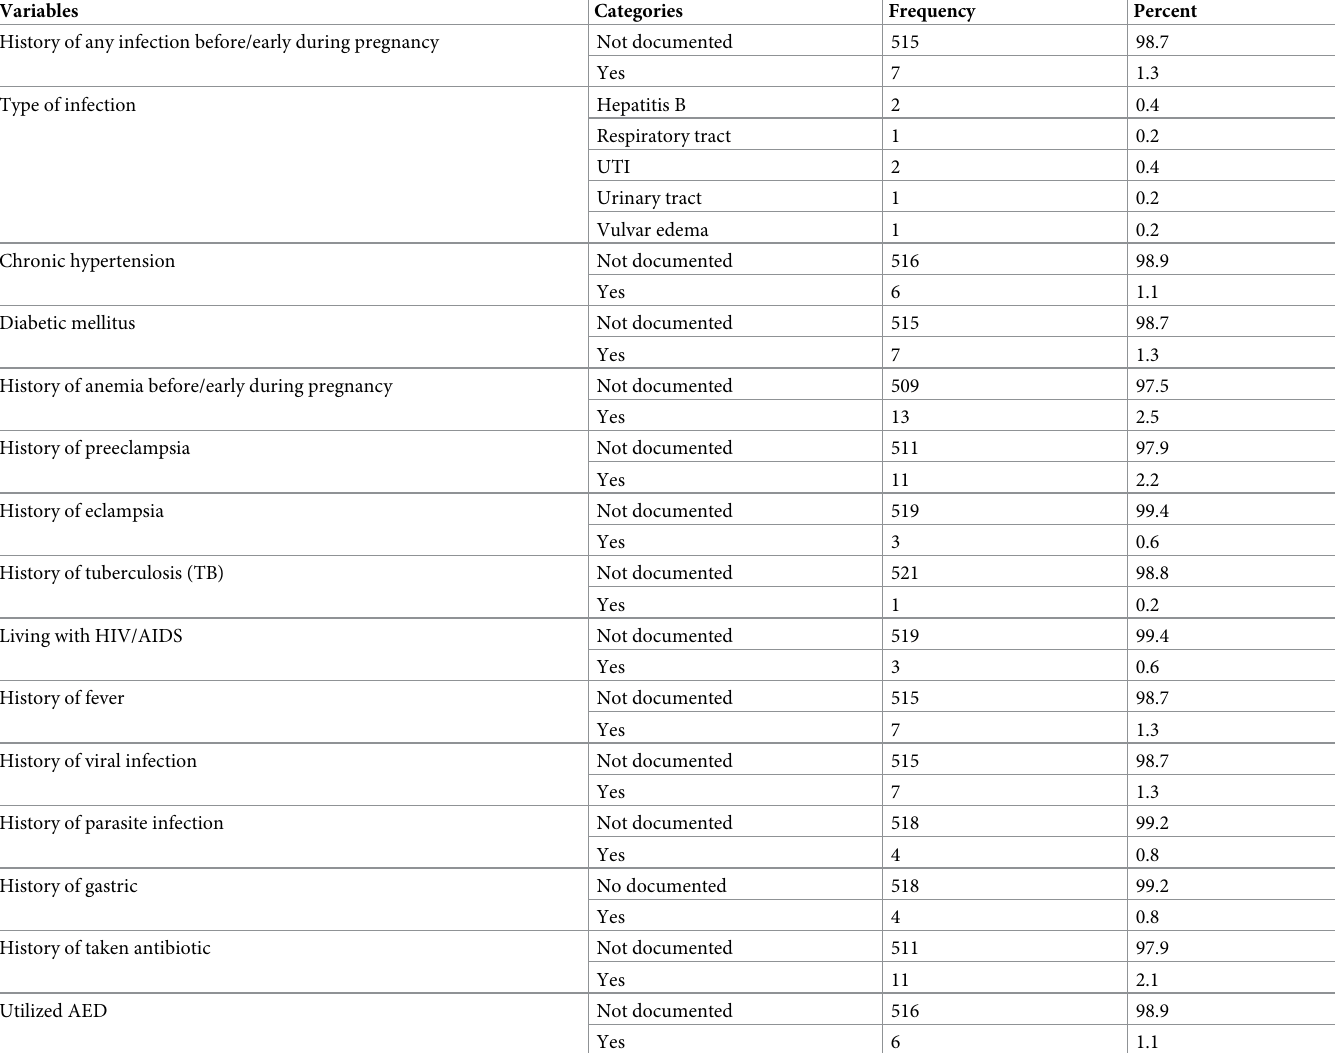
Table 3. Illness and drug history of pregnant women Eastern Ethiopia data from